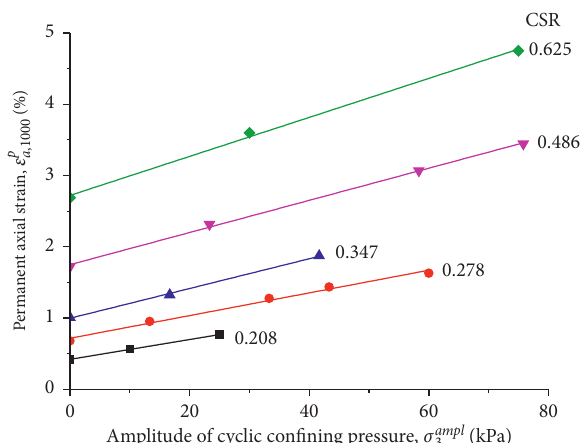
Figure 11: Relationships between the permanent axial strain at N � 1000 versus the amplitude of cyclic confining pressure.